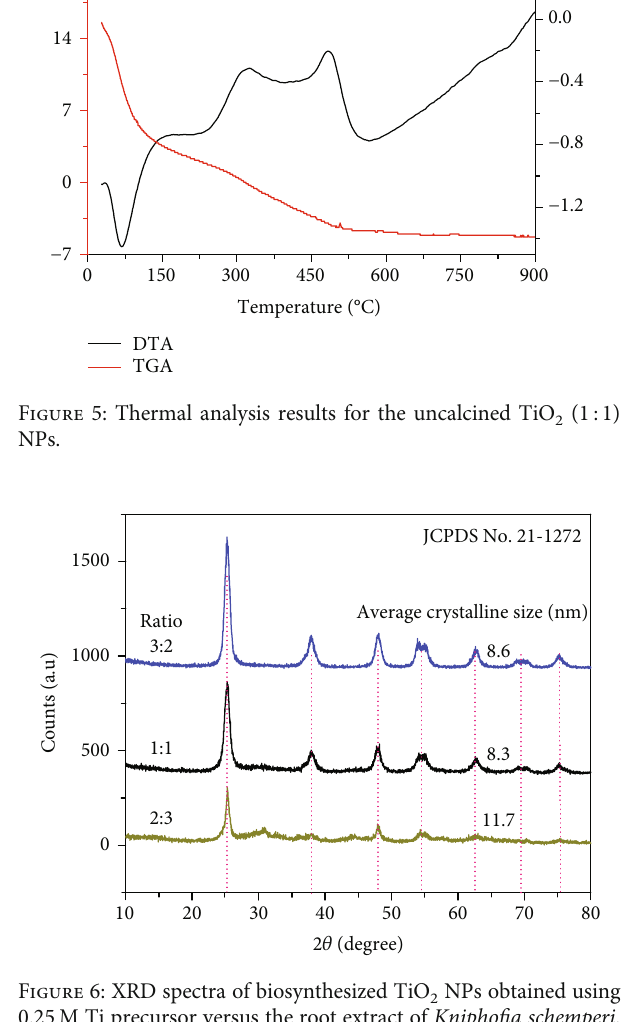
NPs obtained using 2